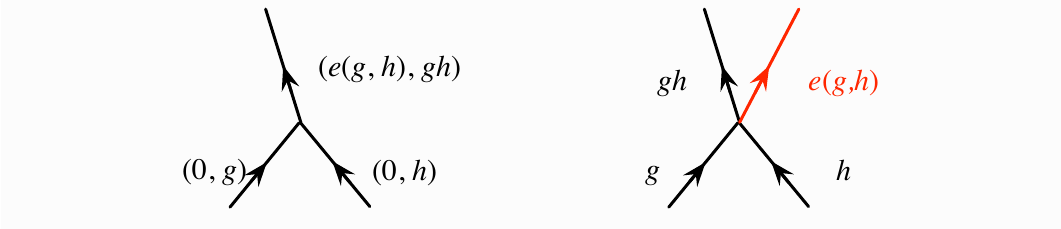
Figure 3: Domain walls for Γ as domain walls for A × G such that domain walls of A can have boundaries as determined by the extension class e .